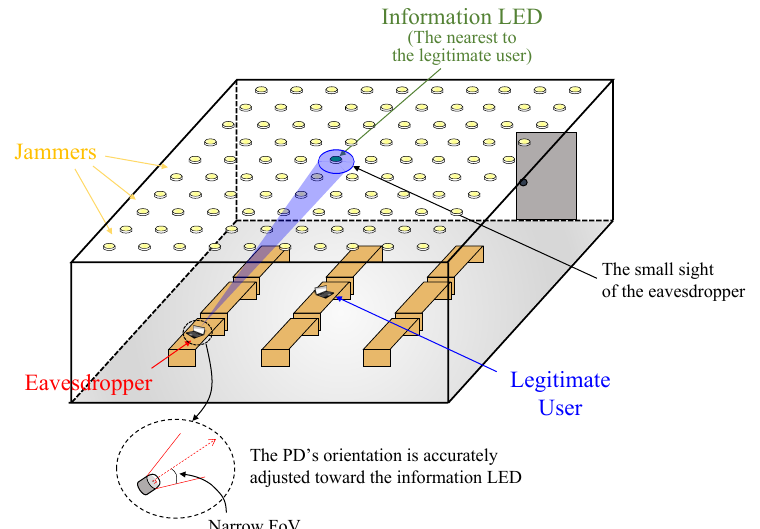
Figure 3. An example of VLC systems with a jamming strategy, where electron device (ED) is equipped with a narrow field-of-view (FoV) photodiode (PD), oriented directly toward information LED